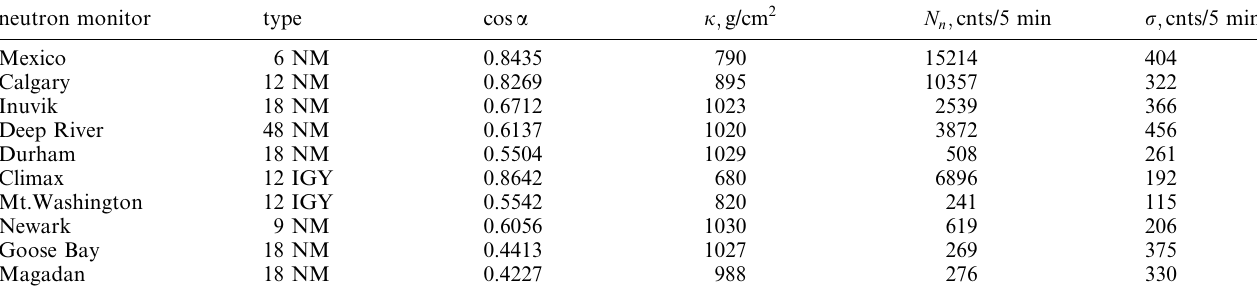
Table 1. Responses of neutron monitors to the solar-neutron event of 24 May 1990 during the interval 2050–2055 UT neutron monitor type Mexico 6